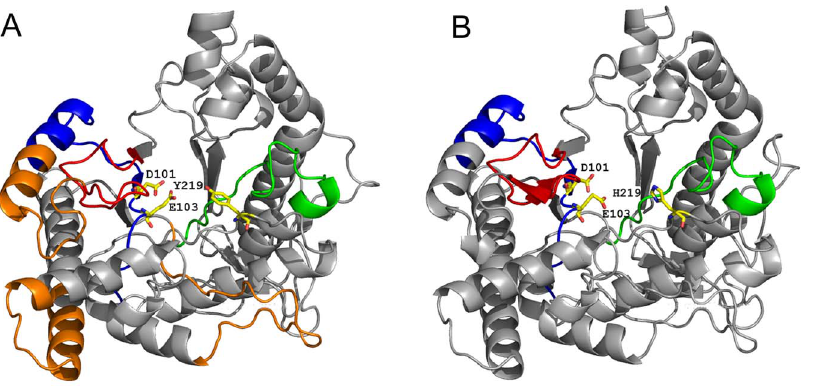
Figure 8. Molecular modeling of TsHyal-1 and TsHyal-2. 3D models for (A) TsHyal-1 and (B) TsHyal-2 were predicted using the crystal structures of Human Hyaluronidase 1 (PDB code: 2PE4) and Apis mellifera venom Hyaluronidase (PDB code: 1FCQ) and the software package Modeller 9.11. Identified epitopes were spatially localized to the surfaces of TsHyal-1 and TsHyal-2. Epitopes common to both isoforms are in red, green, and blue, whereas the epitopes found exclusively in TsHyal-1 are marked in orange. Active site residues D 101 and E 103 localize to antigenic regions in both isoforms and are represented in the active site groove. An active site amino acid variation exists between both isoforms. TsHyal-1 has tyrosine (Y) at position 219, whereas TsHyal-2 has a histidine (H) at the same position. This difference alters the active site groove slightly and may affect the substrate specificity of each isoform.